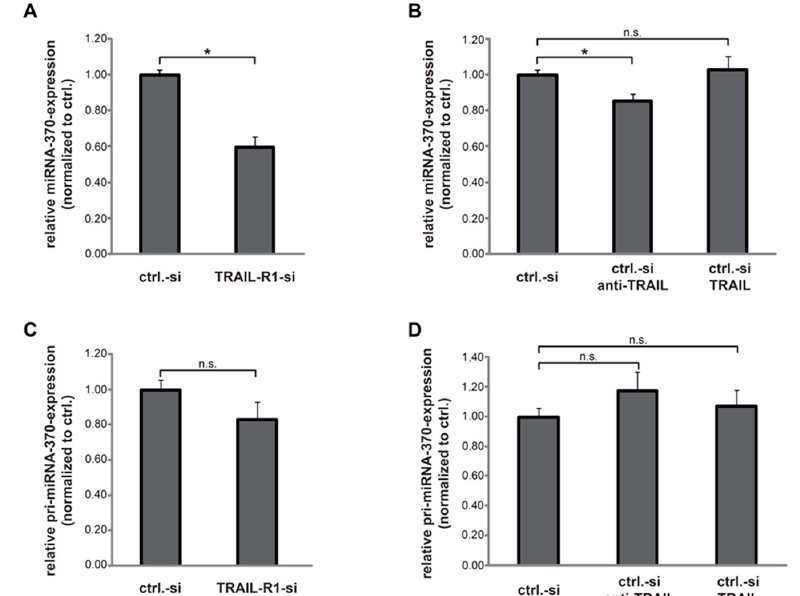
Figure 1. Downregulation of tumour necrosis factor-related apoptosis-inducing ligand-receptor 1 (TRAIL-R1) decreases levels of mature miR-370-3p but not of pri-miR-370. ( A ) Quantitative PCR analyses detecting changes in the levels of mature miR-370-3p in Panc1 cells transfected for 40 h with a control-siRNA (ctrl.-si) or siRNA against TRAIL-R1 (TRAIL-R1-si). ( B ) Panc1 cells transfected with ctrl.-si were stimulated with anti-TRAIL (10 µ g/mL), TRAIL (10 ng/mL) or left untreated. Levels of mature miR-370-3p were quantified by qPCR. ( C , D ) QPCR analyses of pri-miR-370 levels in Panc1 cells transiently transfected with ctrl.-si or TRAIL-R1-si ( C ) or in ctrl.-si transfected cells with and without treatment with TRAIL (10 ng/mL) or anti-TRAIL (1 µ g/mL) ( D ). Shown are the mean ± SD of five biological replicates ( n = 5), with each one analysed in technical duplicates. The asterisks ( * ) indicate significance ( p < 0.05); n.s.: not